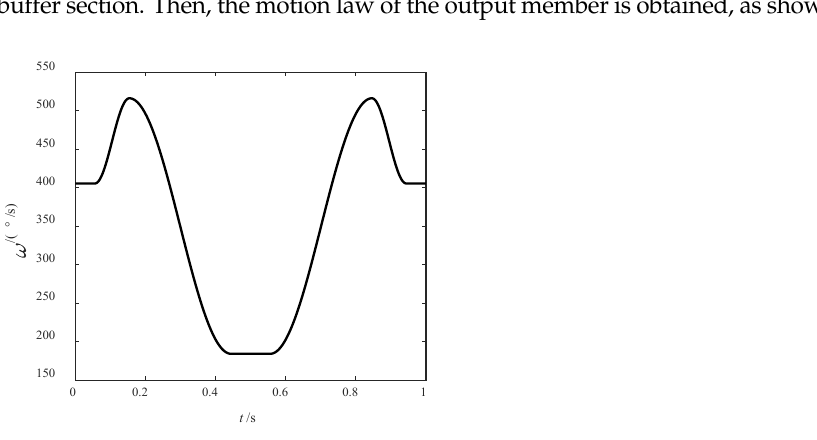
Figure 12 . ω 4 curve before optimization.